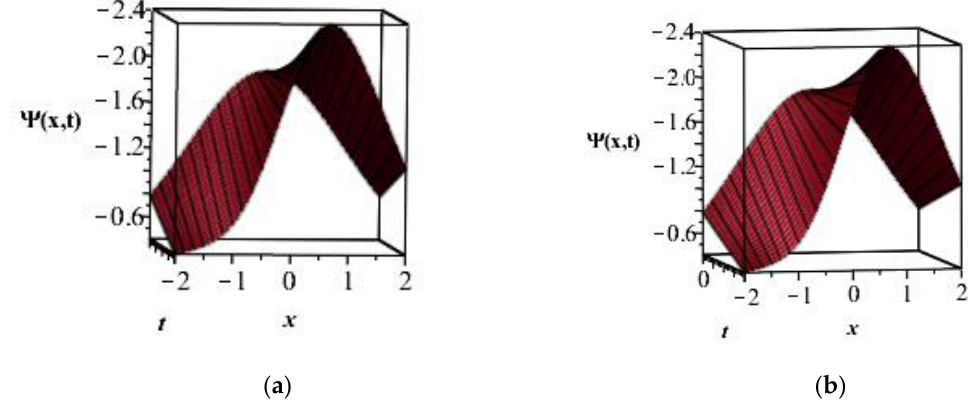
Figure 9. The solution plots of DP equation at α = 1. ( a ) two-terms FRDTM solution ( b ) HPM solution [11]. Table 4. The two term FRDTM approximation results of DP equation with HPM [11] for 1 = .